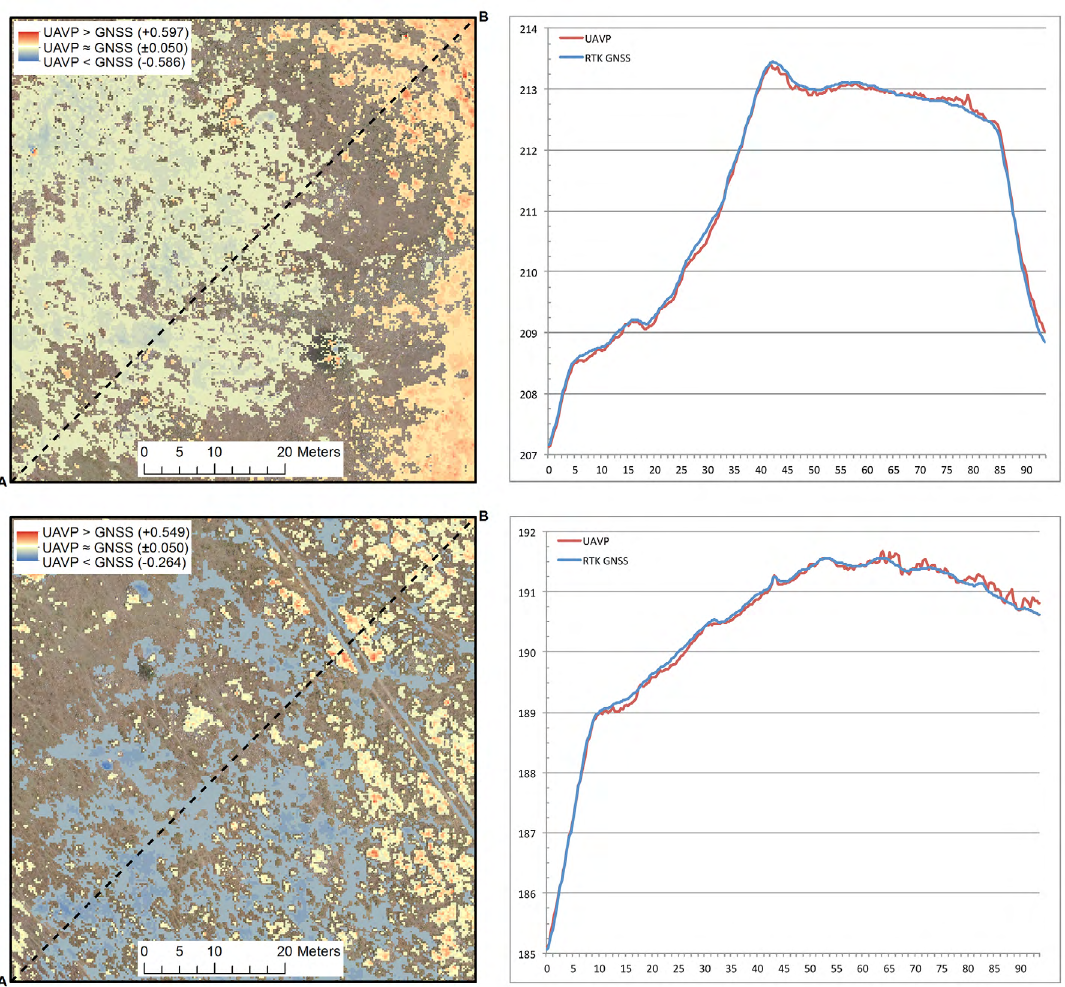
Figure 10: Comparison of data accuracy in Kaymakçı area of interest 1 (top) and area of interest 2 (bottom). The images (left) show the difference rasters representing the subtraction of the RTK GNSS DEMs from the UAVP DEMs, superimposed above orthophotos. The orthophotos are visible through transparent areas where the difference between the two rasters was ≤±0.05m. The graphs (right) show the close match between UAVP and RTK GNSS elevation values along each of the A–B transects, with axes labeled in meters and roughly 14x vertical